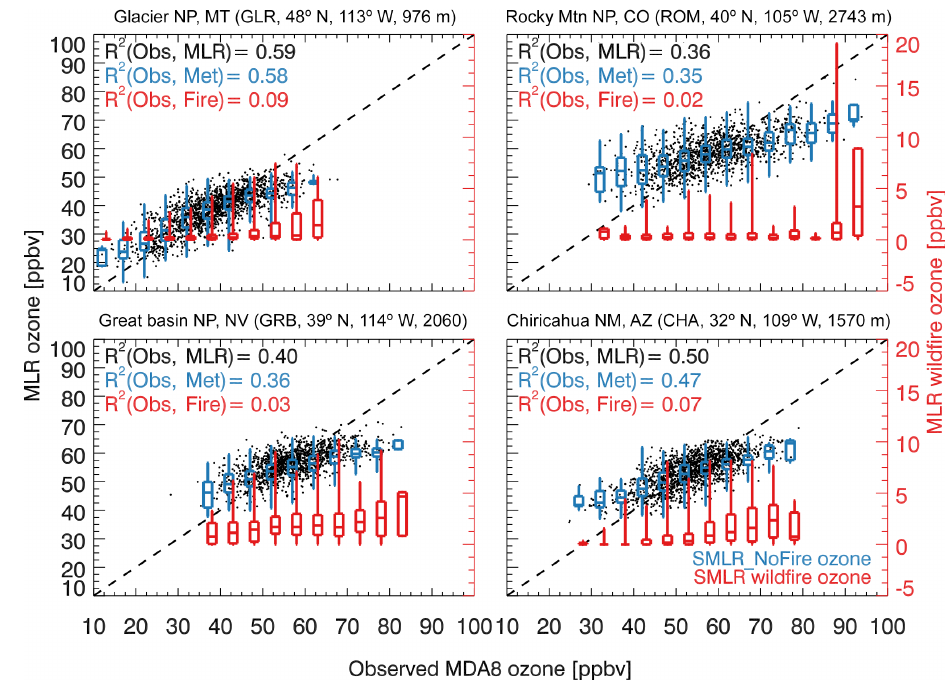
Figure 5. Scatter plots of observed versus MLR predicted MDA8 ozone concentrations at 4 selected CASTNet sites for the summers 1989– 2010. Also shown are the box-and-whisker plots (minimum, 25th, 50th, and 75th percentiles, and maximum) of ozone without wildfire influences (blue) and wildfire ozone enhancements (red) for 5ppbv bins of observed ozone concentrations; both are computed by the MLR model as described in the text. The 1 : 1 line (dashed line) and the coefficient of determination ( R 2 ) are shown